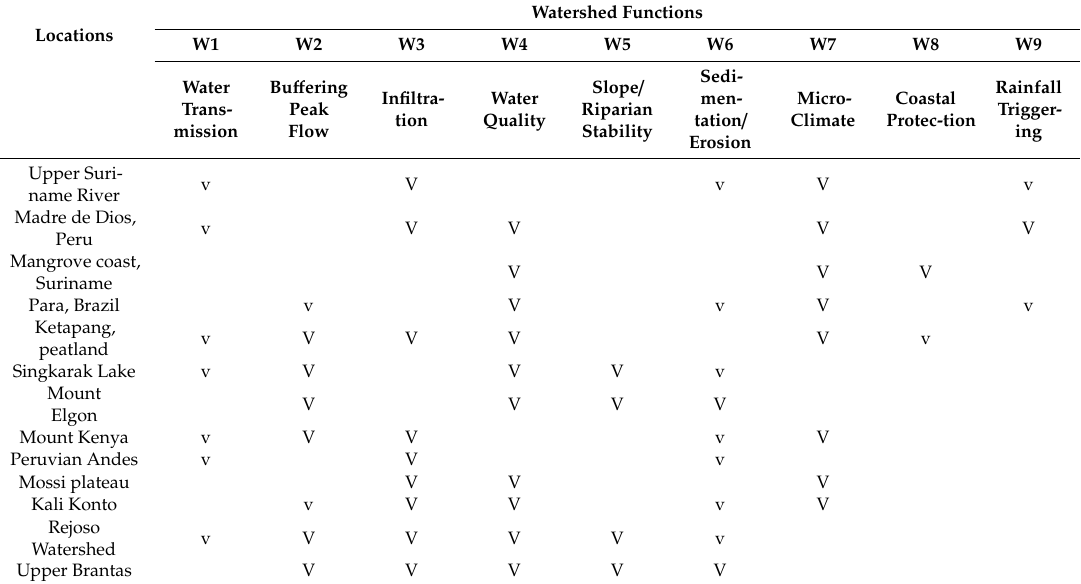
Table 3. Reference (V, major, or v, relevant) to nine ‘watershed issues’ across the various landscapes